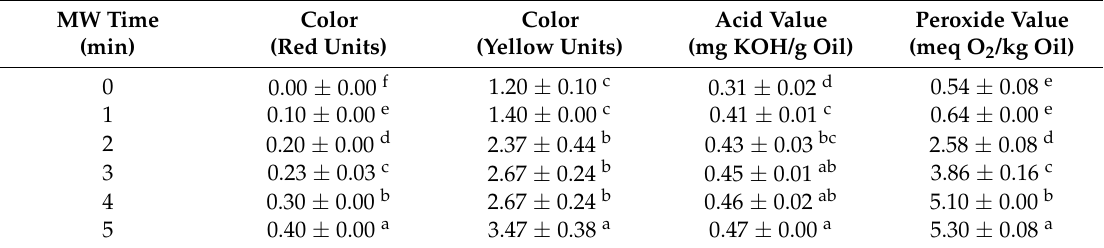
Table 1. Effect of microwave pretreatment on physicochemical properties of